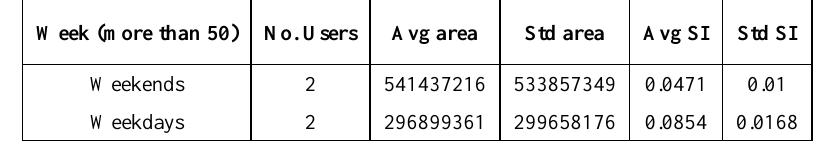
Table 11. Average and standard deviation of area and shape index of users more than 50 based on days of the